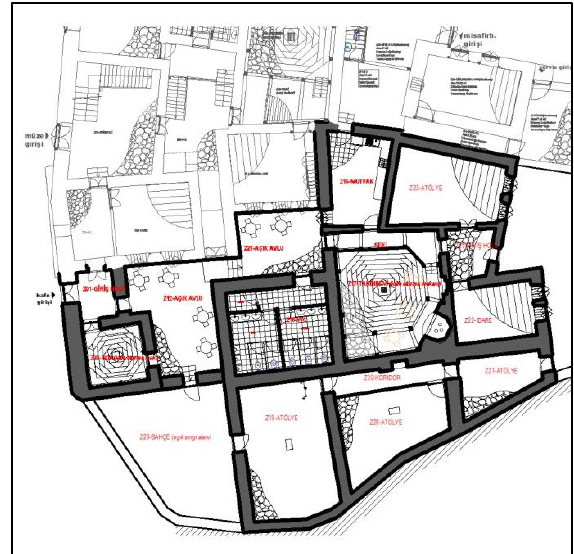
Figure 15. Restoration Project- Spaces of Museum